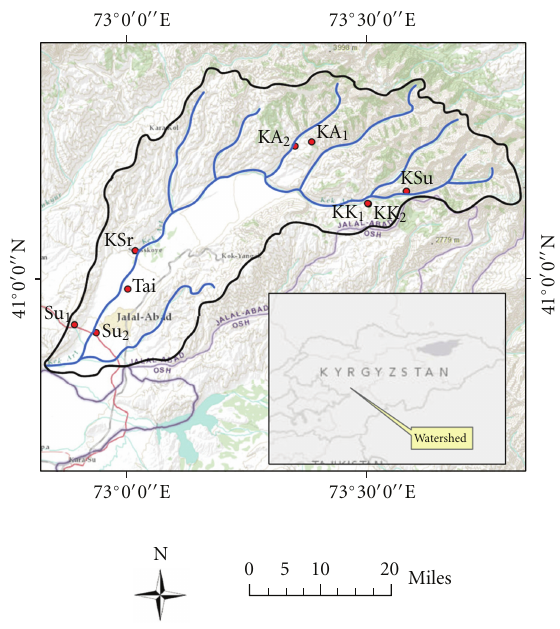
Figure 1: Map showing the Kukart watershed region near Jalal- Abad, Kyrgyzstan where nine soil profiles were characterized for chemical and physical properties and enzymatic activities. See Table 1 for site location details. Briefly, one forested sites is located in Suzak and the other two are in Kara-Alma and indicated on the map as Su 1 , KA 1 , and KA 2 , respectively. The pasture sites are located in Kyzyl-Senir (KSr), Kalmak Kyrchyn (KK 1 ), and Kyzyl-Suu (KSu). The cultivated sites are located in Suzak (Su 2 ), Taigara (Tai), and Kalmak-Kyrchyn (KK 2 ).